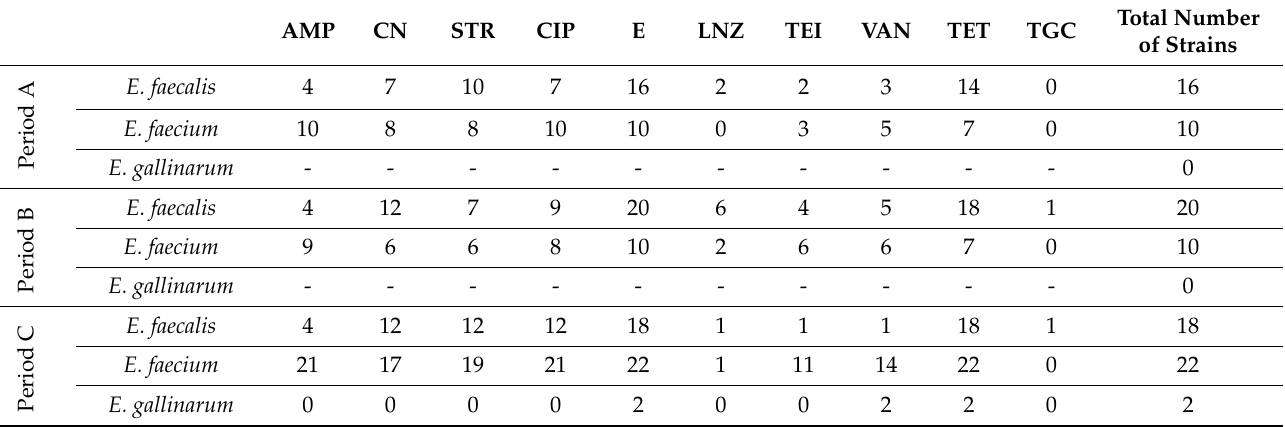
Table 8. Distribution of resistant strains of E. faecalis , E. faecium , and E. gallinarum during the periods of this study.